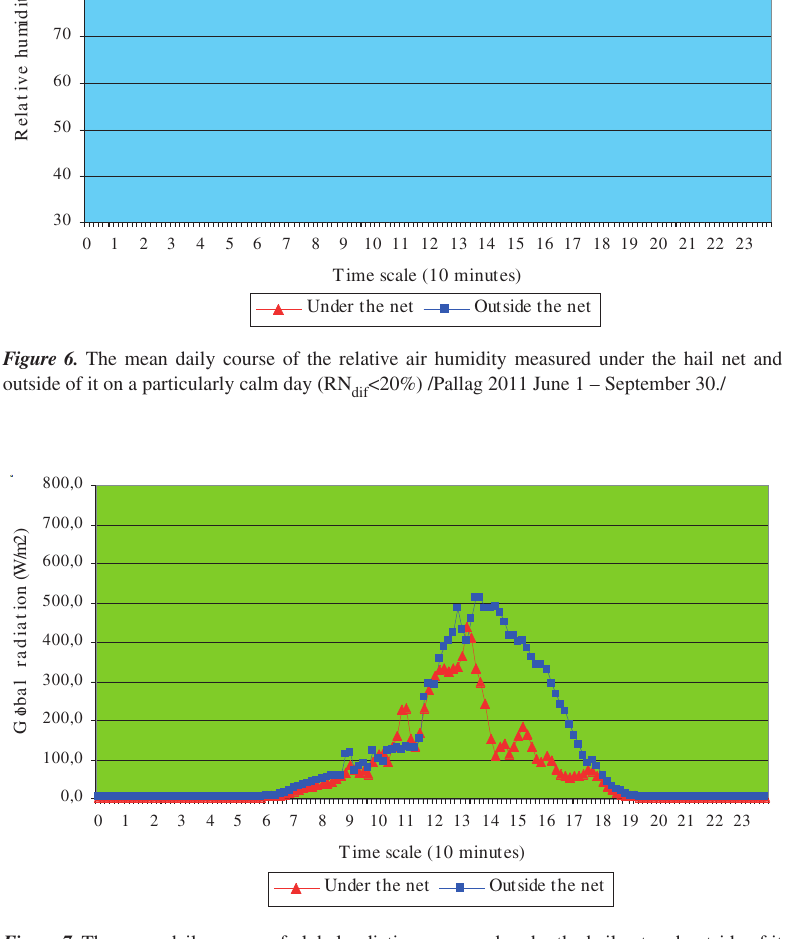
Figure 7. The mean daily course of global radiation measured under the hail net and outside of it /Pallag 2011 June 1 – September 30./